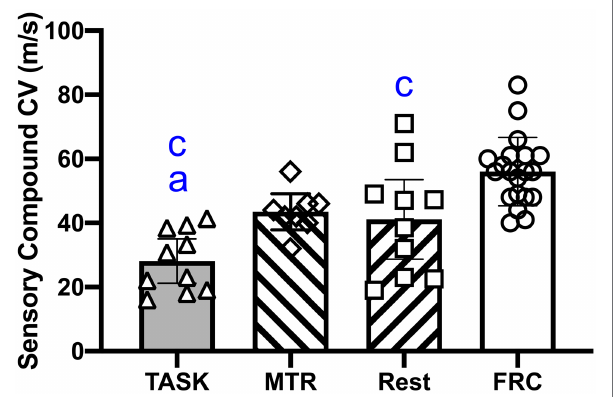
FIGURE 3 | Median nerve conduction velocity (NCV). Symbols: a and c : p < 0.05 each, compared to the MTR and FRC groups, respectively. Mean ± 95% CI